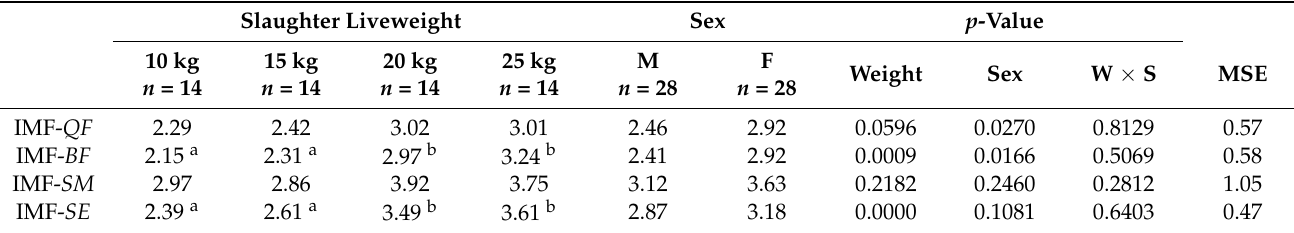
Table 4. Means and mean square errors of the percentage of IMF samples obtained from the QFQ, BF, SM and SE muscles, in the four weight groups and in male and female groups.